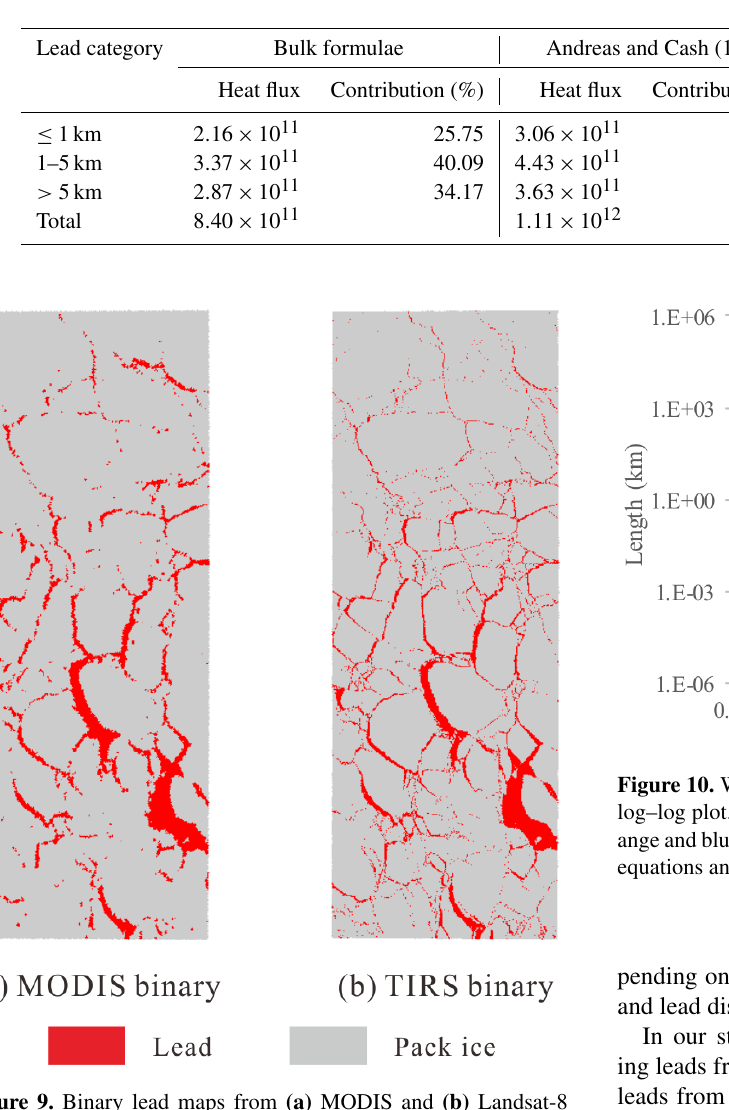
Table 3. Estimated turbulent heat flux ( W ) for Landsat-8 TIRS using bulk formulae, the Andreas and Cash (1999) model, and the modified Andreas and Cash model using Obukhov length from Eqs. (B8) and (B13).